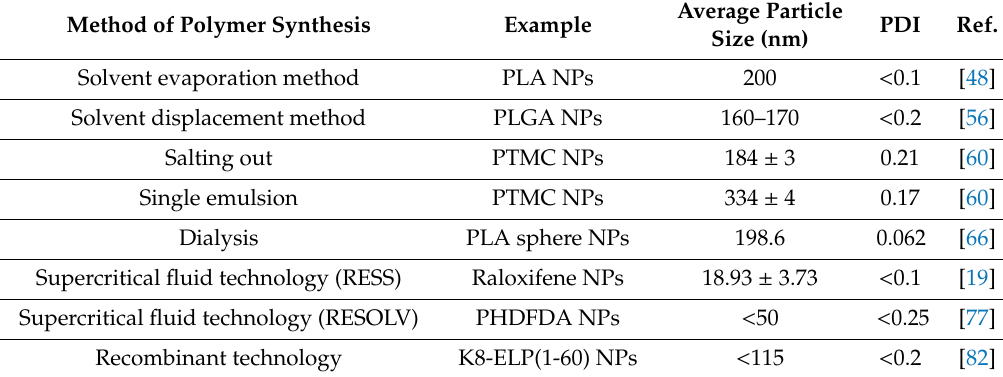
Table 2. Comparison of average particle size and polydispersity index (PDI) between various synthesis